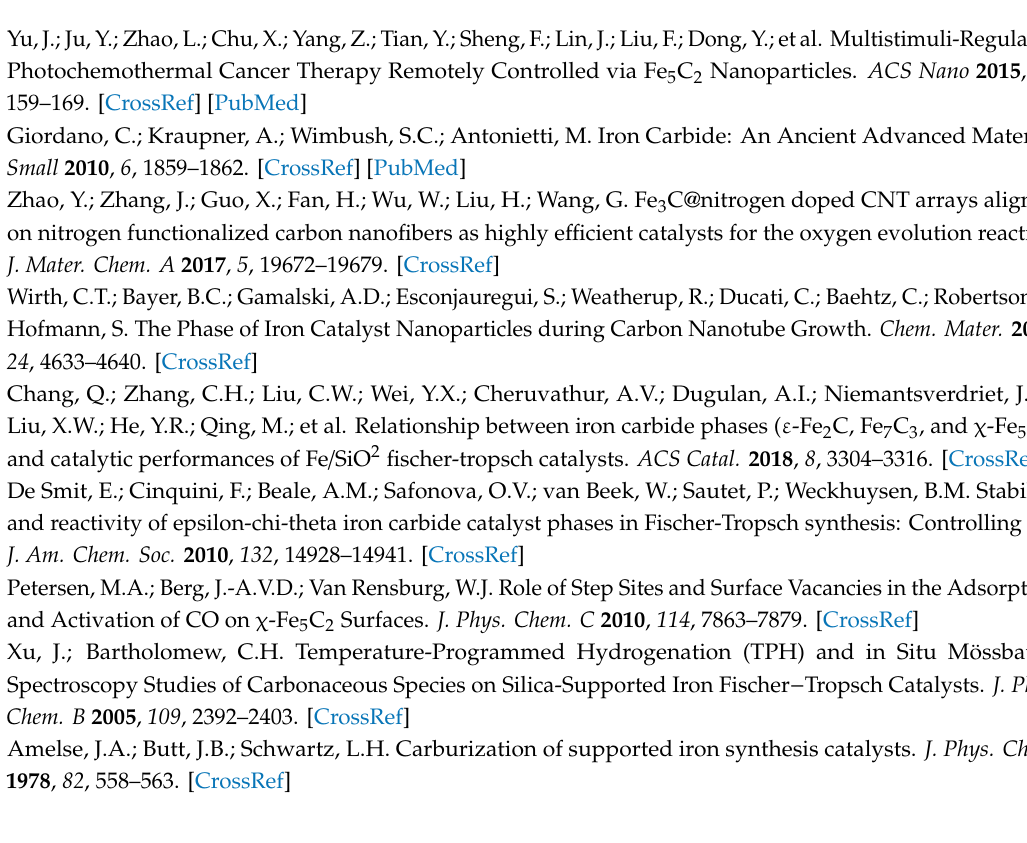
Figure S1. The energy profiles of C 2 H 4 dissociation on Fe(110), as well as the top and side view of the configurations for the corresponding intermediates. Figure S2. The energy profiles of C 2 H 4 dissociation on Fe(110)-K 2 O, as well as the top and side view of the configurations for the corresponding intermediates. Figure S3. The energy profiles of C 2 H 4 dissociation on Fe(211), as well as the top and side view of the configurations for the corresponding intermediates. Figure S4. The energy profiles of C 2 H 4 dissociation on Fe(211)-K 2 O, as well as the top and side view of the configurations for the corresponding intermediates. Figure S5. The energy profiles of CO / H 2 dissociation on Fe(110), as well as the top and side view of the configurations for the corresponding intermediates. Figure S6. The energy profiles of CO / H 2 dissociation on Fe(110)-K 2 O, as well as the top and side view of the configurations for the corresponding intermediates. Figure S7. The energy profiles of CO / H 2 dissociation on Fe(211), as well as the top and side view of the configurations for the corresponding intermediates. Figure S8. The energy profiles of CO / H 2 dissociation on Fe(211)-K 2 O, as well as the top and side view of the configurations for the corresponding intermediates. Figure S9. The top and side view structures of 2CH + H, C + CH + 3H and 2C + 4H on Fe(110). Table S1. The distances between the two atoms ( d , Å) be dissociated in the transition states of the element steps for C 2 H 4 and CO / H 2 dissociation on Fe(110), Fe(110)-K 2 O, Fe(211) and Fe(211)-K 2 O